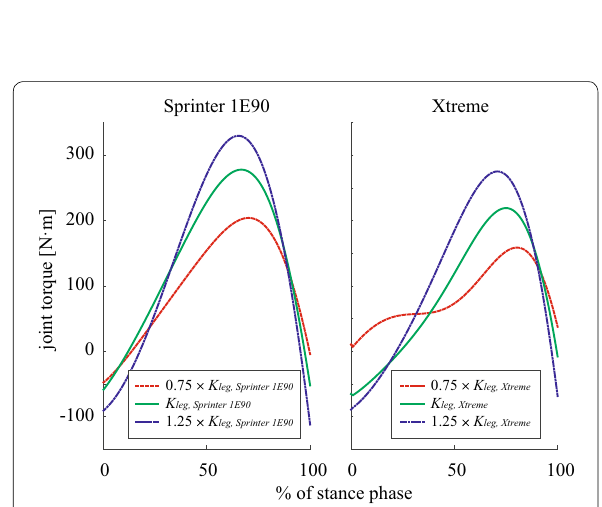
Fig. 7 Simulated left hip joint torque during the stance phase with different types of RSPs. Left graph: Sprinter 1E90, right graph: Xtreme, red dotted line: 75% of K leg , green solid line: 100% of K leg , and blue dashed-dotted line: 125% of K